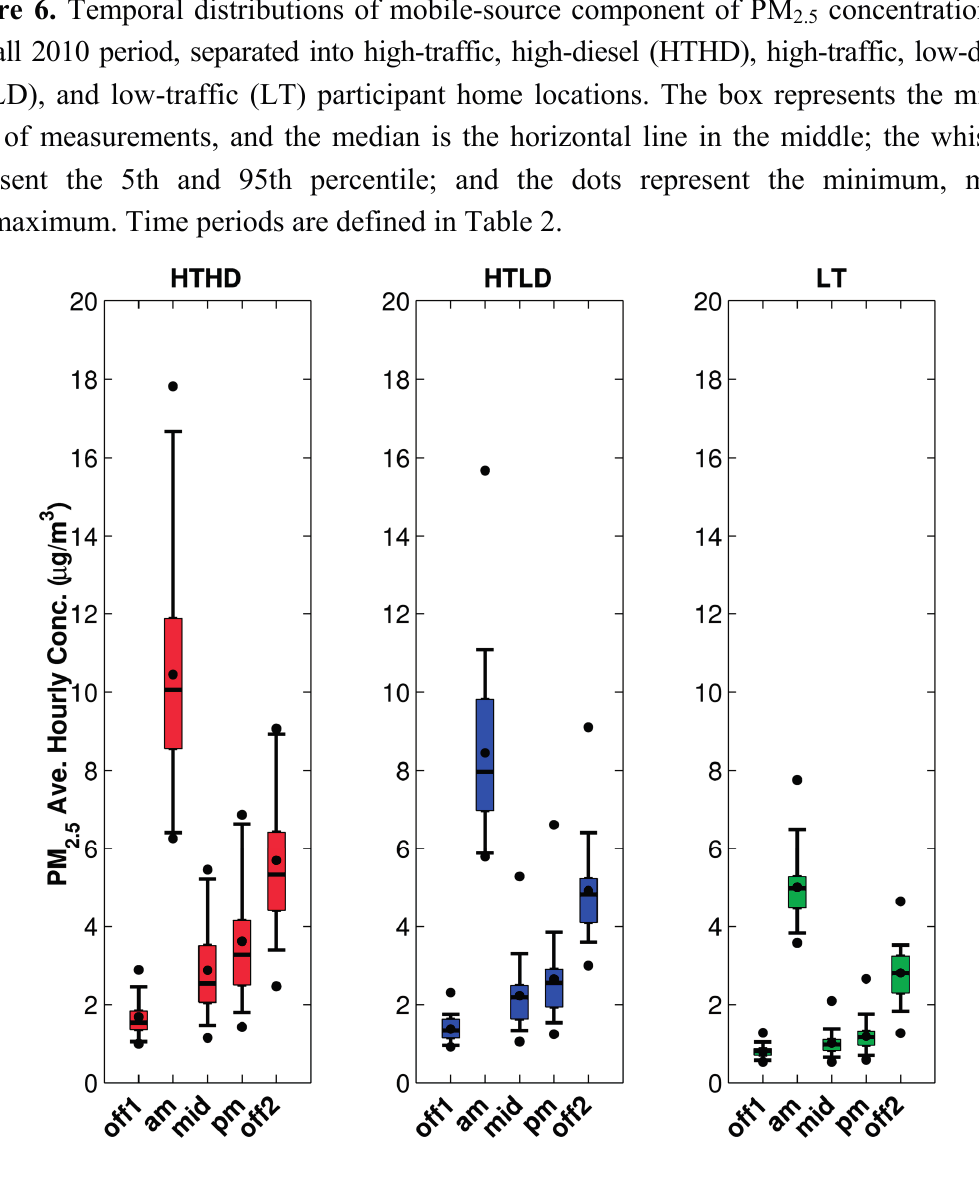
concentration for 2.5